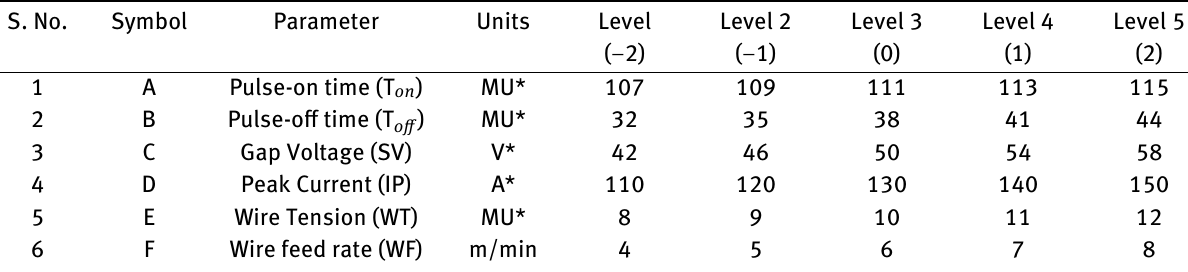
Table 2: Experimental factors and their levels for machining process S.